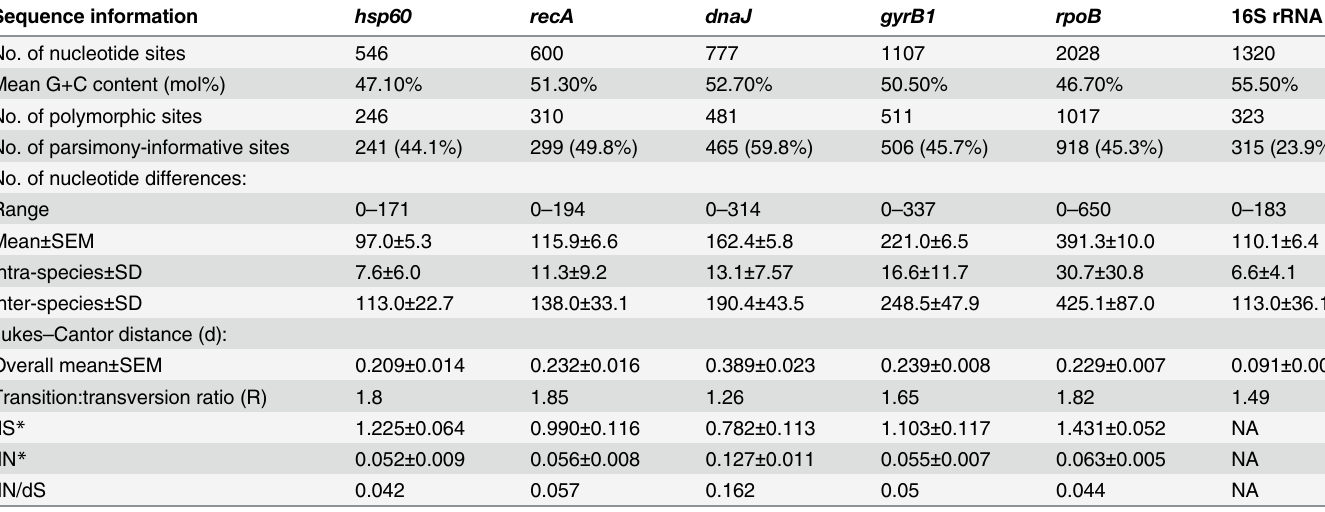
Table 3. Analysis of 106 hsp60 , recA , dnaJ , gyrB1 , rpoB and 16S rRNA gene sequences from Prevotella